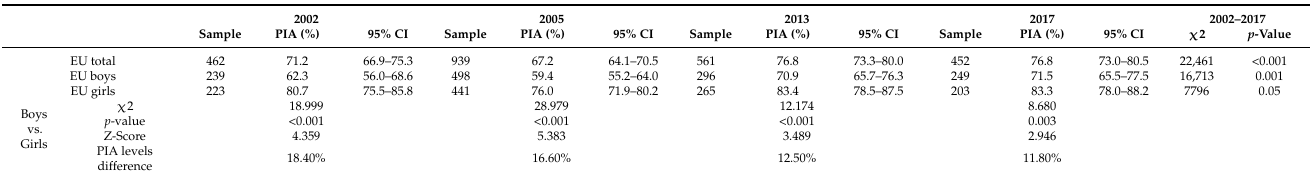
Table 1. Levels (%) of physical inactivity (PIA) in adolescents (15–17 years old) in the European Union (EU) countries in 2002, 2005, 2013, and